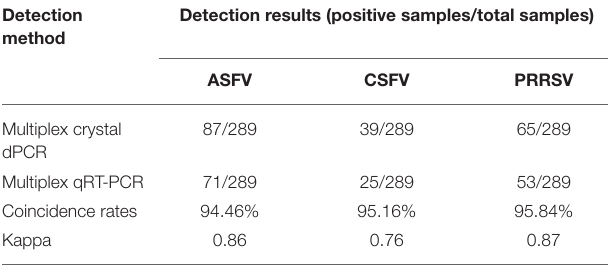
TABLE 6 | Agreements between the multiplex crystal dPCR and the multiplex qRT-PCR. Detection